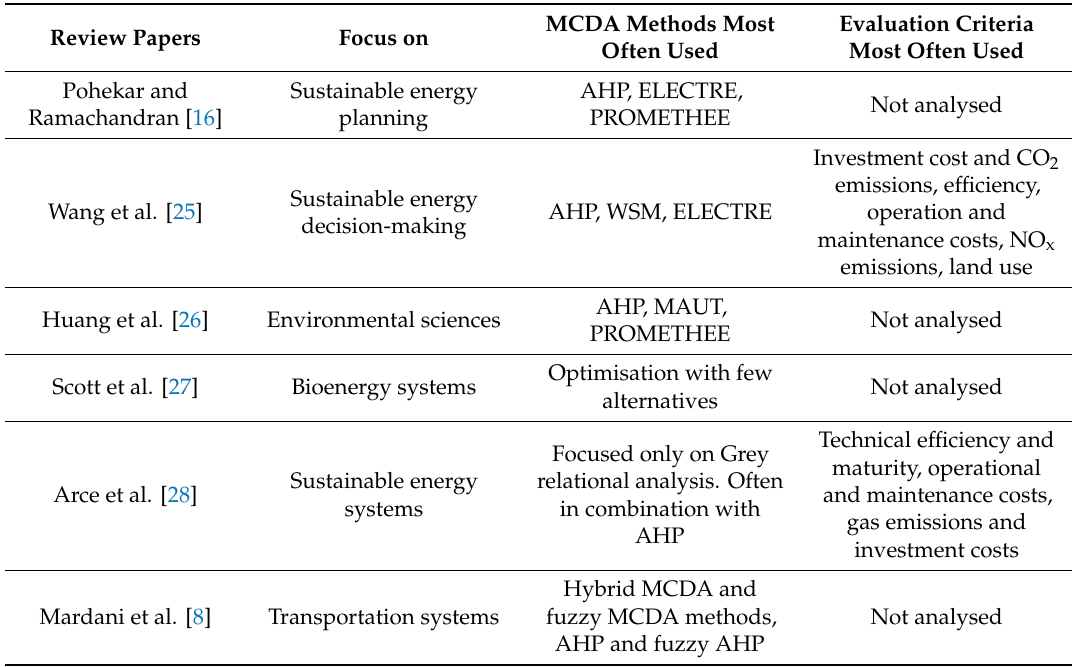
Table 3. Overview over similar MCDA-related literature